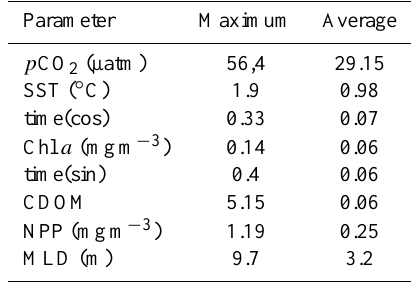
Figure 11. Distribution of the neural map of the coefficient from lin- ear regression for each parameter: (a) SST in ◦ C, (b) and (d) time cosine and sine respectively, (c) Chl a in mgm − 3 , (f) NPP in mgCm − 2 , and (g) MLD in m.